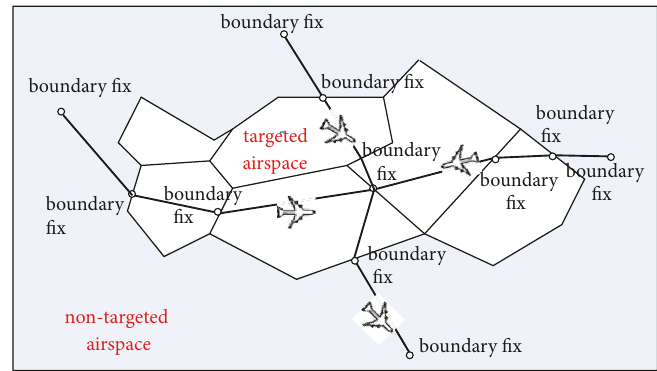
Figure 4: Diagram of en route network.